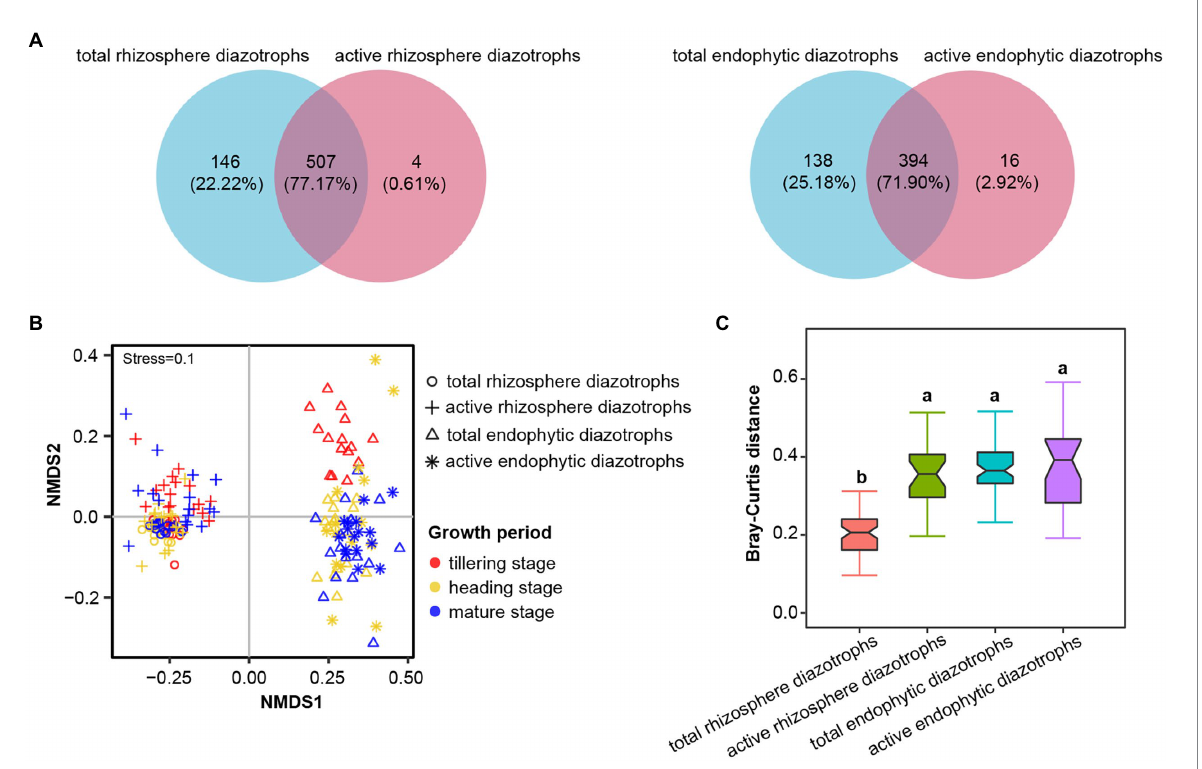
FIGURE 1 Effects of microhabitat on the community composition of total (DNA-derived) and active (RNA-derived) root-associated diazotrophs in 2016. (A) Venn diagrams showing the unique and shared OTUs between DNA and RNA samples in rhizosphere soil (at the tillering, heading and mature stages) and roots (at the heading and mature stages) in 2016. (B) Nonmetric multidimensional scaling (NMDS) ordinations based on the Bray– Curtis distance matrix of the total and active diazotrophic communities in rhizosphere soil and root samples in 2016. (C) Bray–Curtis distances of diazotrophic communities between soil DNA samples, soil RNA samples, root DNA samples or root RNA samples in 2016. Different lowercase letters indicate significant differences between these libraries ( p < 0.05, Tukey’s HSD